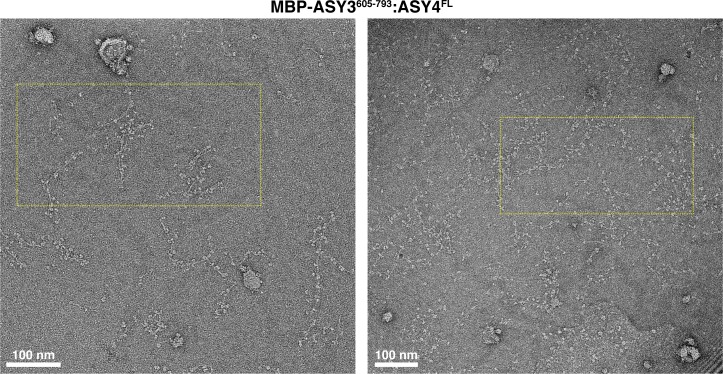
Electron micrographs of At ASY3:ASY4 filaments.Negative-stain electron micrographs of A. thaliana His6-MBP-ASY3605-793:ASY4FL filaments. Yellow dotted boxes indicate the area of micrographs shown in Figure 5F.